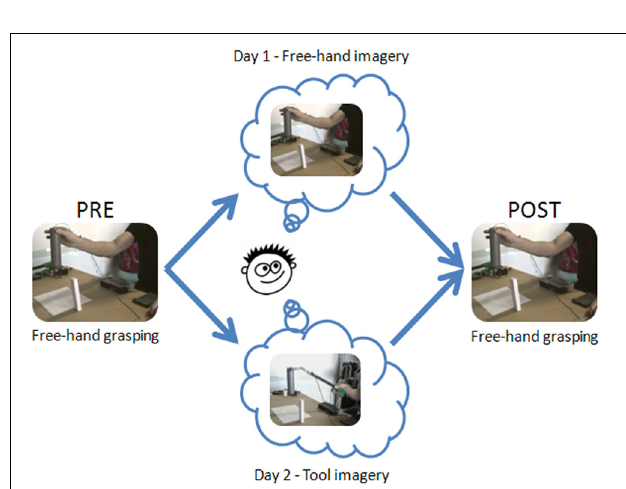
two colored dots indicating the location of the fingers (red for the thumb and yellow for the index); the line between these two dots constituted the opposition axis, which could be of three orientations: − 22 ◦ , 0 ◦ and + 22 ◦ . On the left an arrow indicated the height to which the object should be lifted.